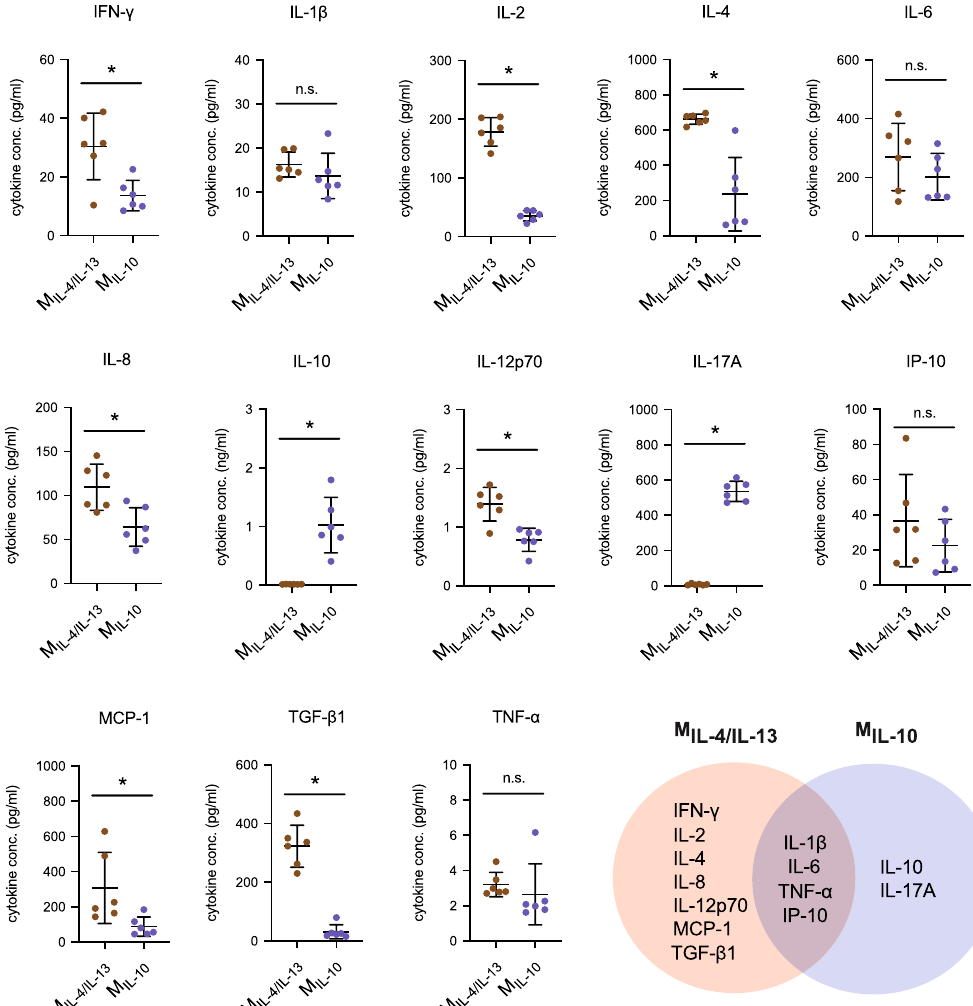
Fig. 3 Quantitative analysis of cytokine secretion pro fi le of M IL-4/IL-13 and M IL-10 . Cytokine secretion pro fi le was analyzed from cell culture supernatants after 3 days of macrophage activation by a bead-based multiplex immunoassay using fl ow cytometry. Data are shown as a dot plot. Black line and error bar in the plot represent mean and standard deviation, respectively. * indicates a signi fi cance level of p ≤ 0.05 using Mann – Whitney test. Experiments were performed in six independent